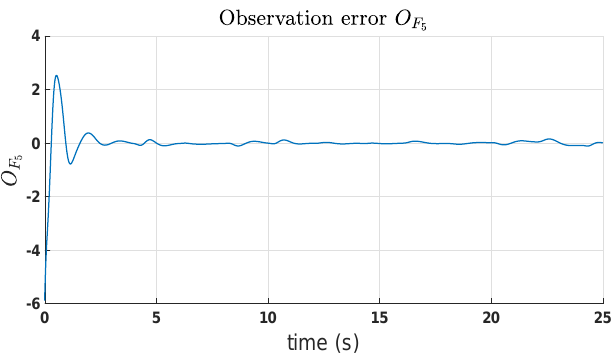
Figure 16. Observation error dynamics O F